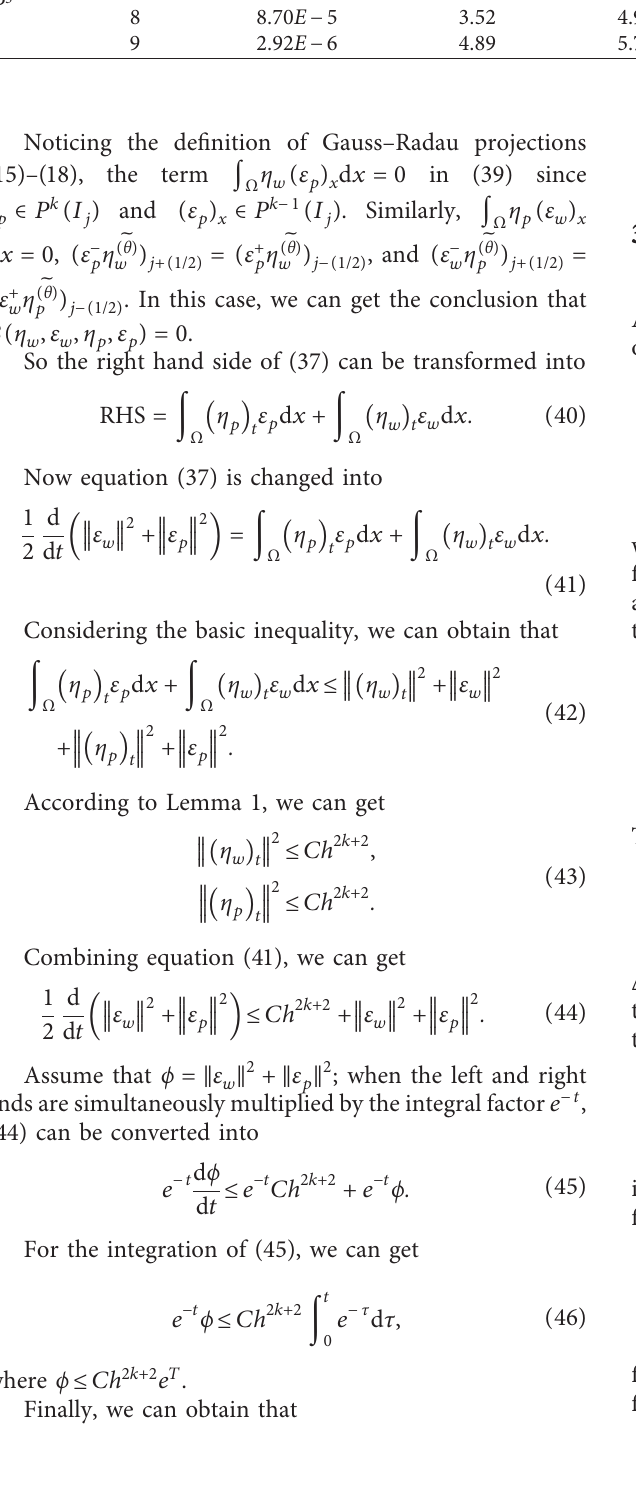
Table 1: The L 2 spatial errors and order of convergence of w θ � 0 . m